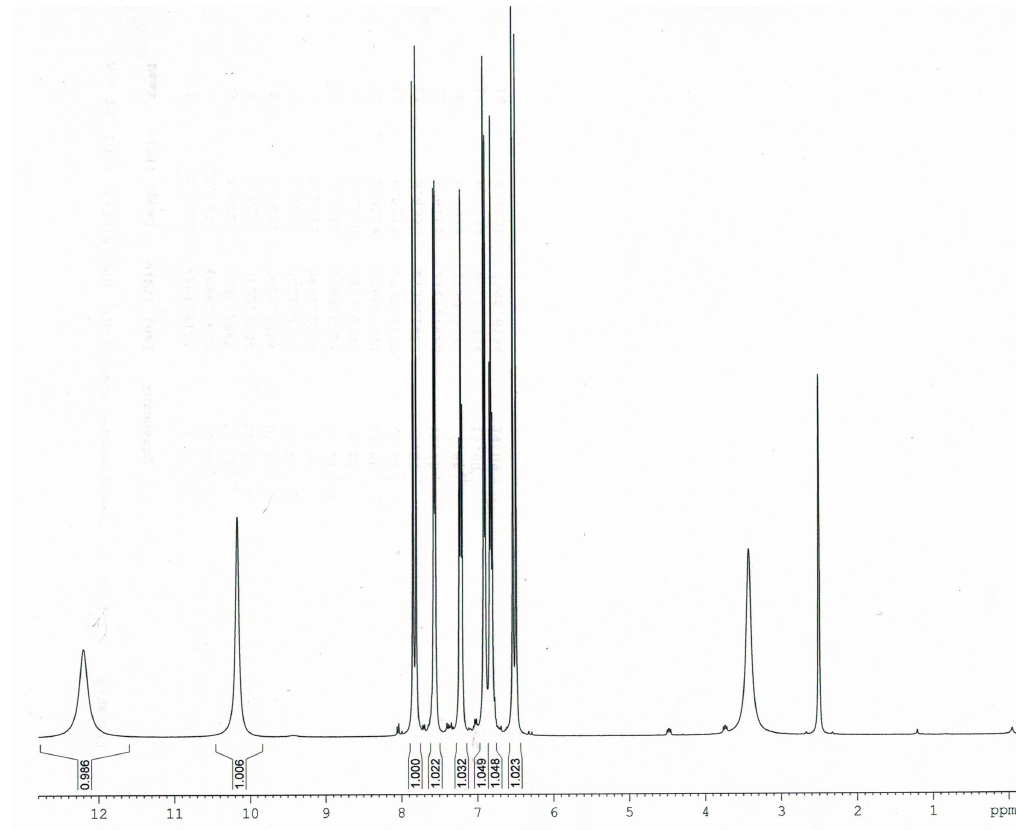
Figure 4. Experimental 1 H-NMR spectrum of trans o- coumaric acid.